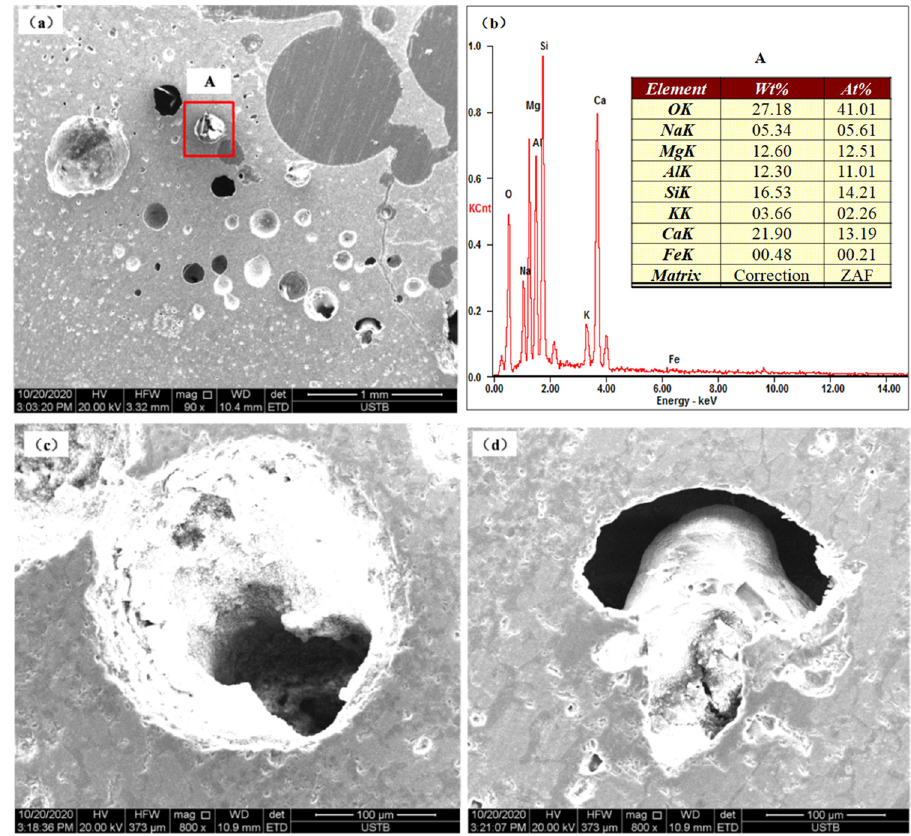
Figure 2: Micro morphology of slag after reaction. ( a ) Holes of di ff erent sizes; ( b ) EDS results of point A; ( c ) horn shaped hole; ( d ) internal morphology of the